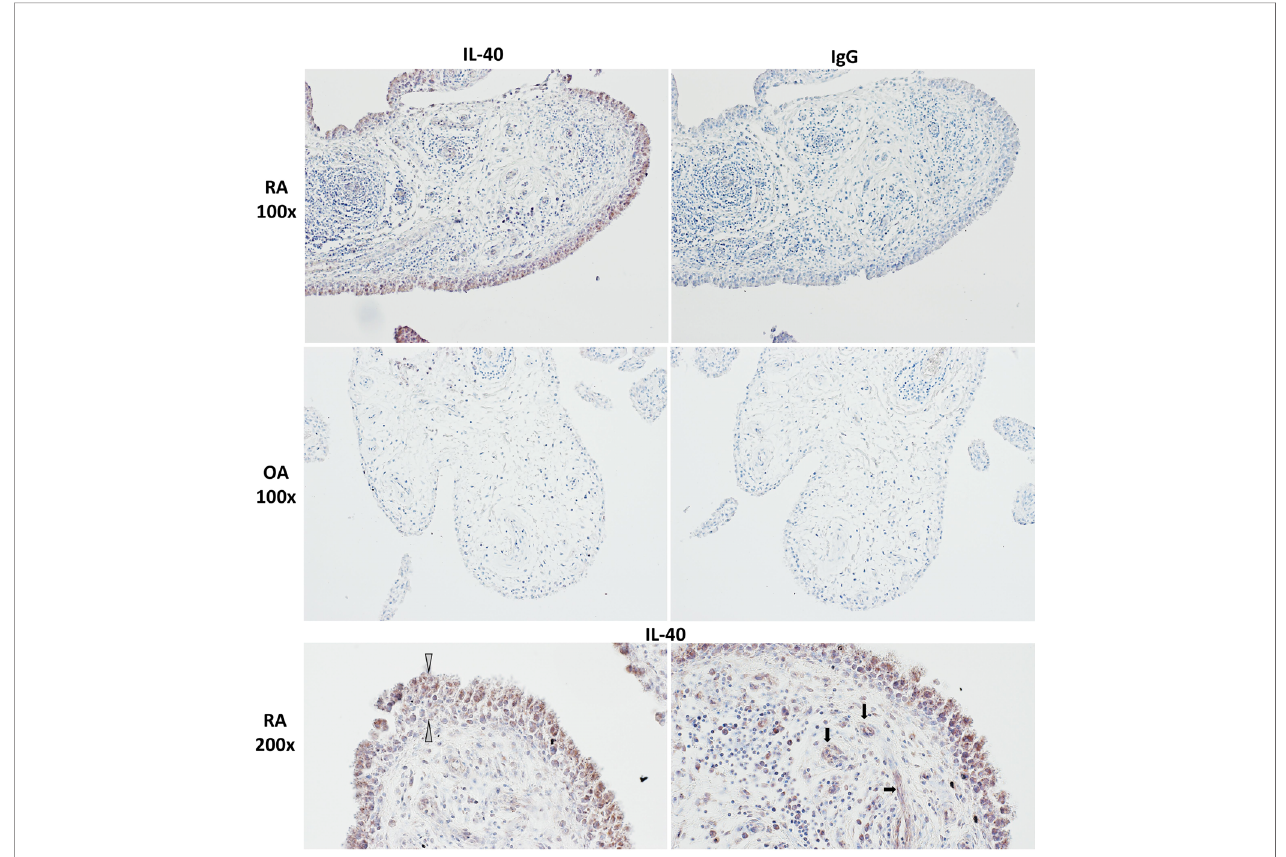
FIGURE 1 | IL-40 in the synovial membrane of patients with rheumatoid arthritis (RA) and osteoarthritis (OA). Intensive IL-40 positivity was observed in RA, especially in the hyperplastic lining layer and within the in fl ammatory in fi ltrates of the RA synovium. Moderate expression of IL-40 was detected in the endothelial cells. IL-40 expression was quite sparse with only few IL-40 positive immune cells within the OA synovial tissue. Rabbit IgG was used as an isotype control. The white arrows point to the hyperplastic lining layer, and the black arrows point to capillaries. Representative images of immunohistochemistry staining are shown at × 100 magni fi cation, detailed view at × 200 magni fi cation (RA, n = 5; OA, n =